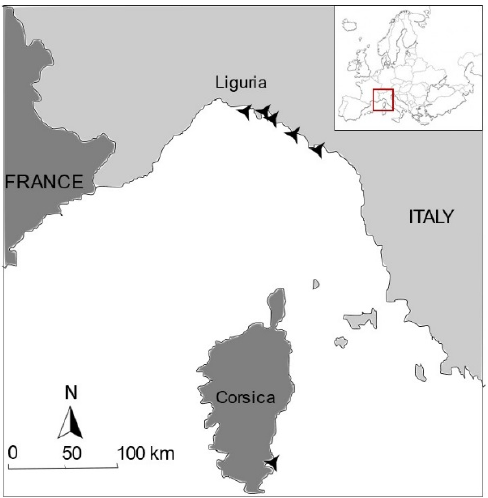
Figure 1. Study area including six P. oceanica meadows in the regions of Liguria (Italy) and Corsica (France), located in the north-west of Mediterranean Sea. Table 1. Coordinates of the two transects surveyed in each of the six meadows investigated. Meadow Location